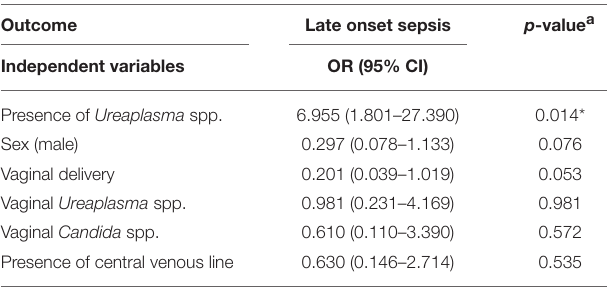
TABLE 3 | Stepwise multivariate logistic regression analysis examining the correlation between Ureaplasma exposure and late onset sepsis.